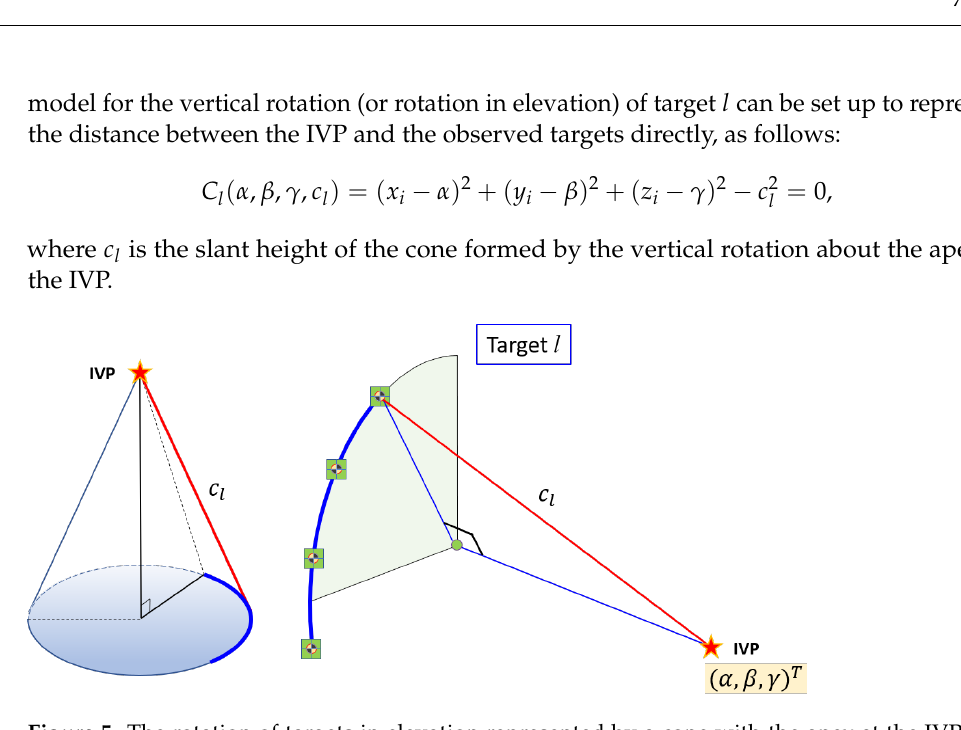
Figure 5. The rotation of targets in elevation represented by a cone with the apex at the IVP. The slant height c l is the individual unknown for each vertical target, while the coordinates of the IVP are common for all